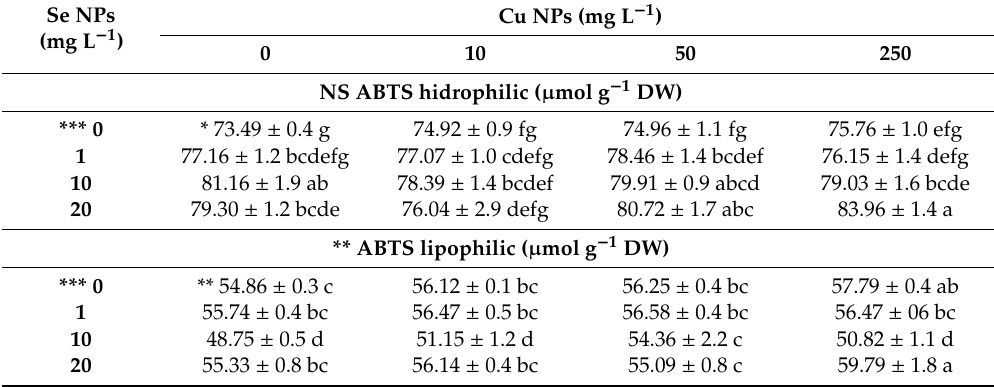
Table 4. ABTS antioxidant capacity in tomato leaves from plants treated with Se and Cu NPs. Se